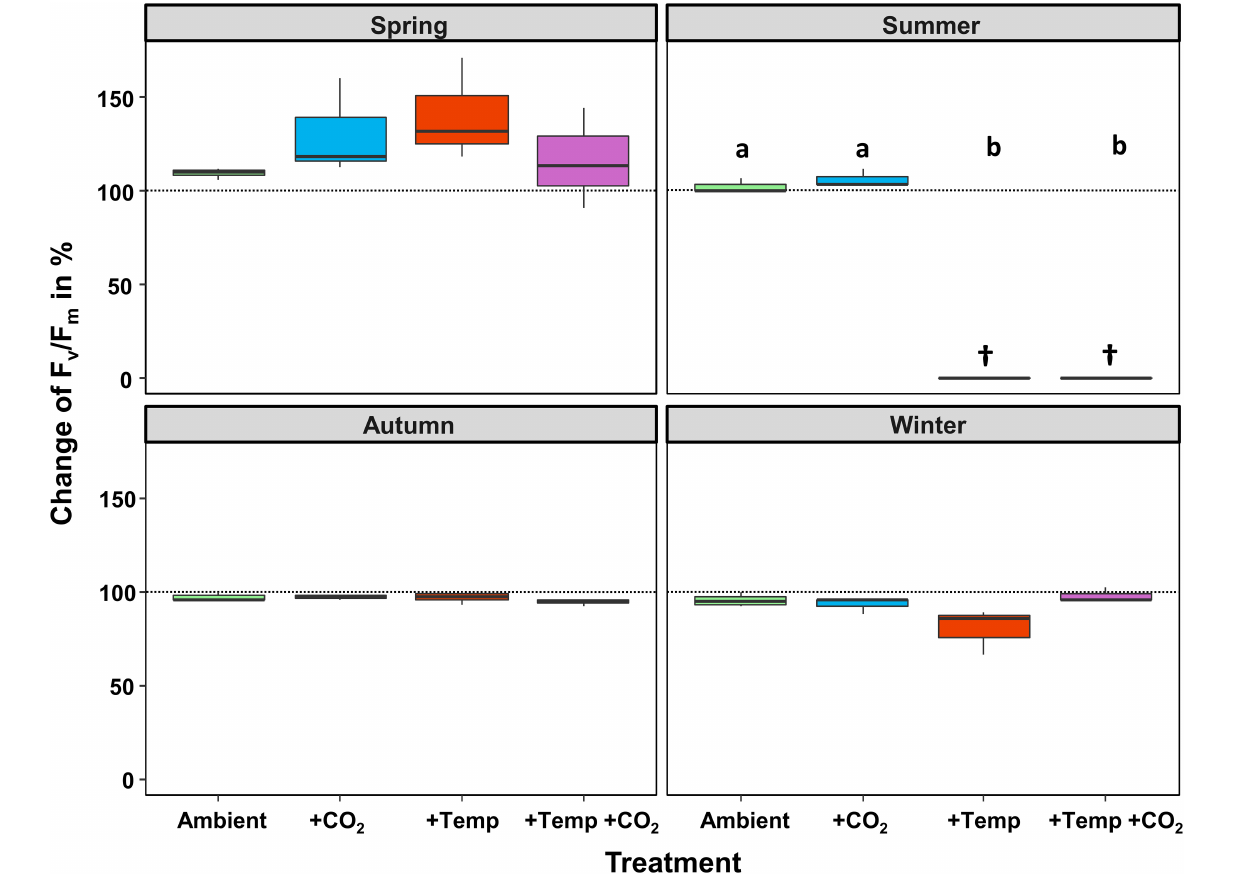
FIGURE 2 | Relative change (as %) between the initial and final state of maximum quantum yield (F v /F m ) of Fucus vesiculosus during experiments in the Kiel Outdoor Benthocosms with various temperature and pCO 2 conditions over different seasons; dashed line represent no change, values above 100% mean higher F v /F m values at the end of the experiment. Seasons: spring: April 4–June 19, 2013; summer: July 4–September 17, 2013; autumn: October 10–December 18, 2013; winter: January 16–April 1, 2014. Temperature and pCO 2 conditions: Ambient: ambient temperature and pCO 2 , +CO 2 : ambient temperature and elevated pCO 2 , +Temp: elevated temperature and ambient pCO 2 , +Temp +CO 2 : elevated temperature and pCO 2 ( n = 3). Cross ( † ) indicates dieback of F. vesiculosus in the summer experiment under warming. Horizontal lines represent the median; boxes, the interquartile range; whiskers, 1.5 × of inter-quartile range. Different lowercase letters indicate significant differences ( p < 0.05; Tukey’s